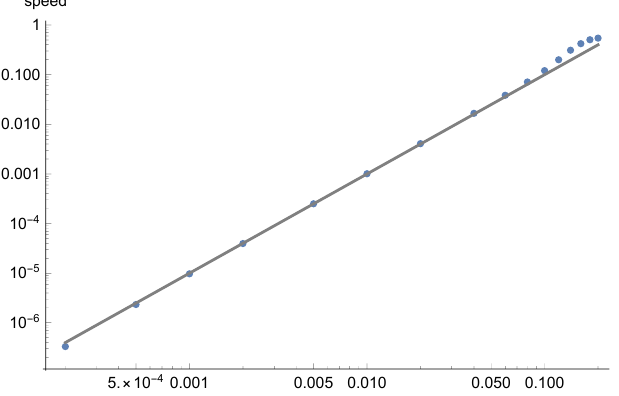
Figure 9 . The rate at which (cid:1)( t ) increases in time obtained from a linear (cid:12)t of (cid:1)( t ) in 0 < t < 30 plotted in the log-log scale. The straight line is 10 (cid:15) 2